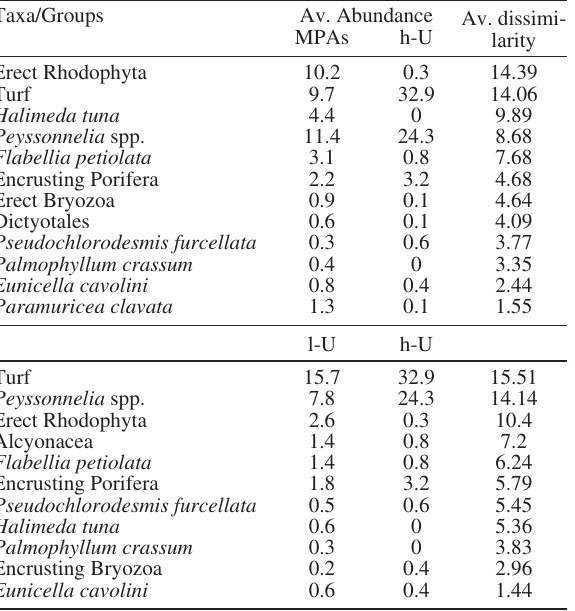
Table 2. – Results of SIMPER test. MPAs, marine protected areas; l-U, low urbanized locations; h-U, highly urbanized locations. Taxa/Groups